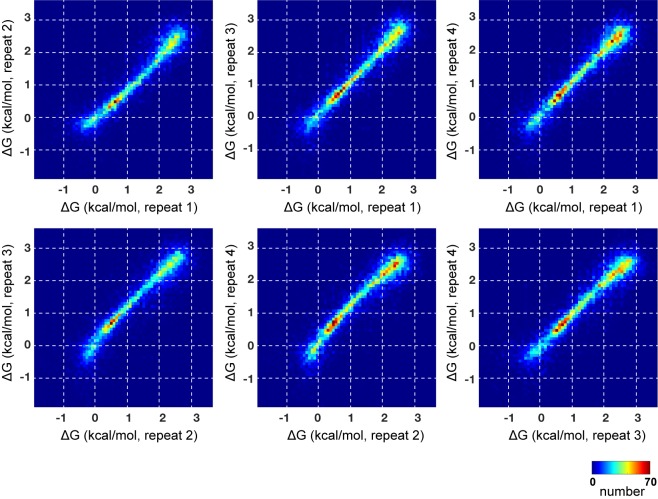
Reproducibility and quality of the bacterial two-hybrid assay.The panels show 2D histograms of all single and double mutant binding free energies for four independent experimental trials of the bacterial two-hybrid assay for PSD95pdz3. The data show that the assay is remarkably reproducible, with >95% of values with a variance less than 0.31 kcal/mol. See Table 1 for counting statistics of all mutants and number of double mutant cycles estimated per PDZ homolog.